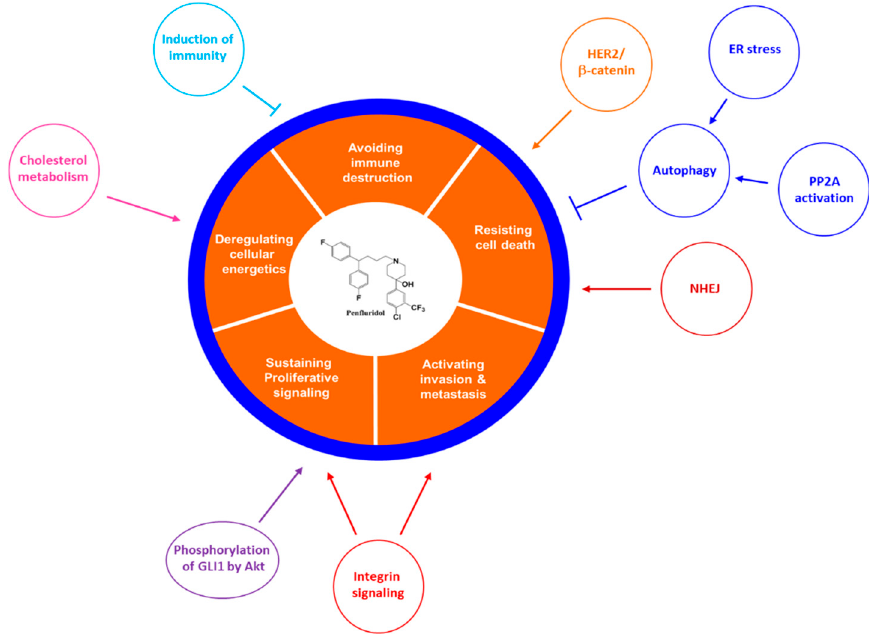
Figure 3. Inhibitory mechanisms of penfluridol on the hallmarks of cancer. Cancer hallmarks not yet studied with penfluridol are not shown in the figure.